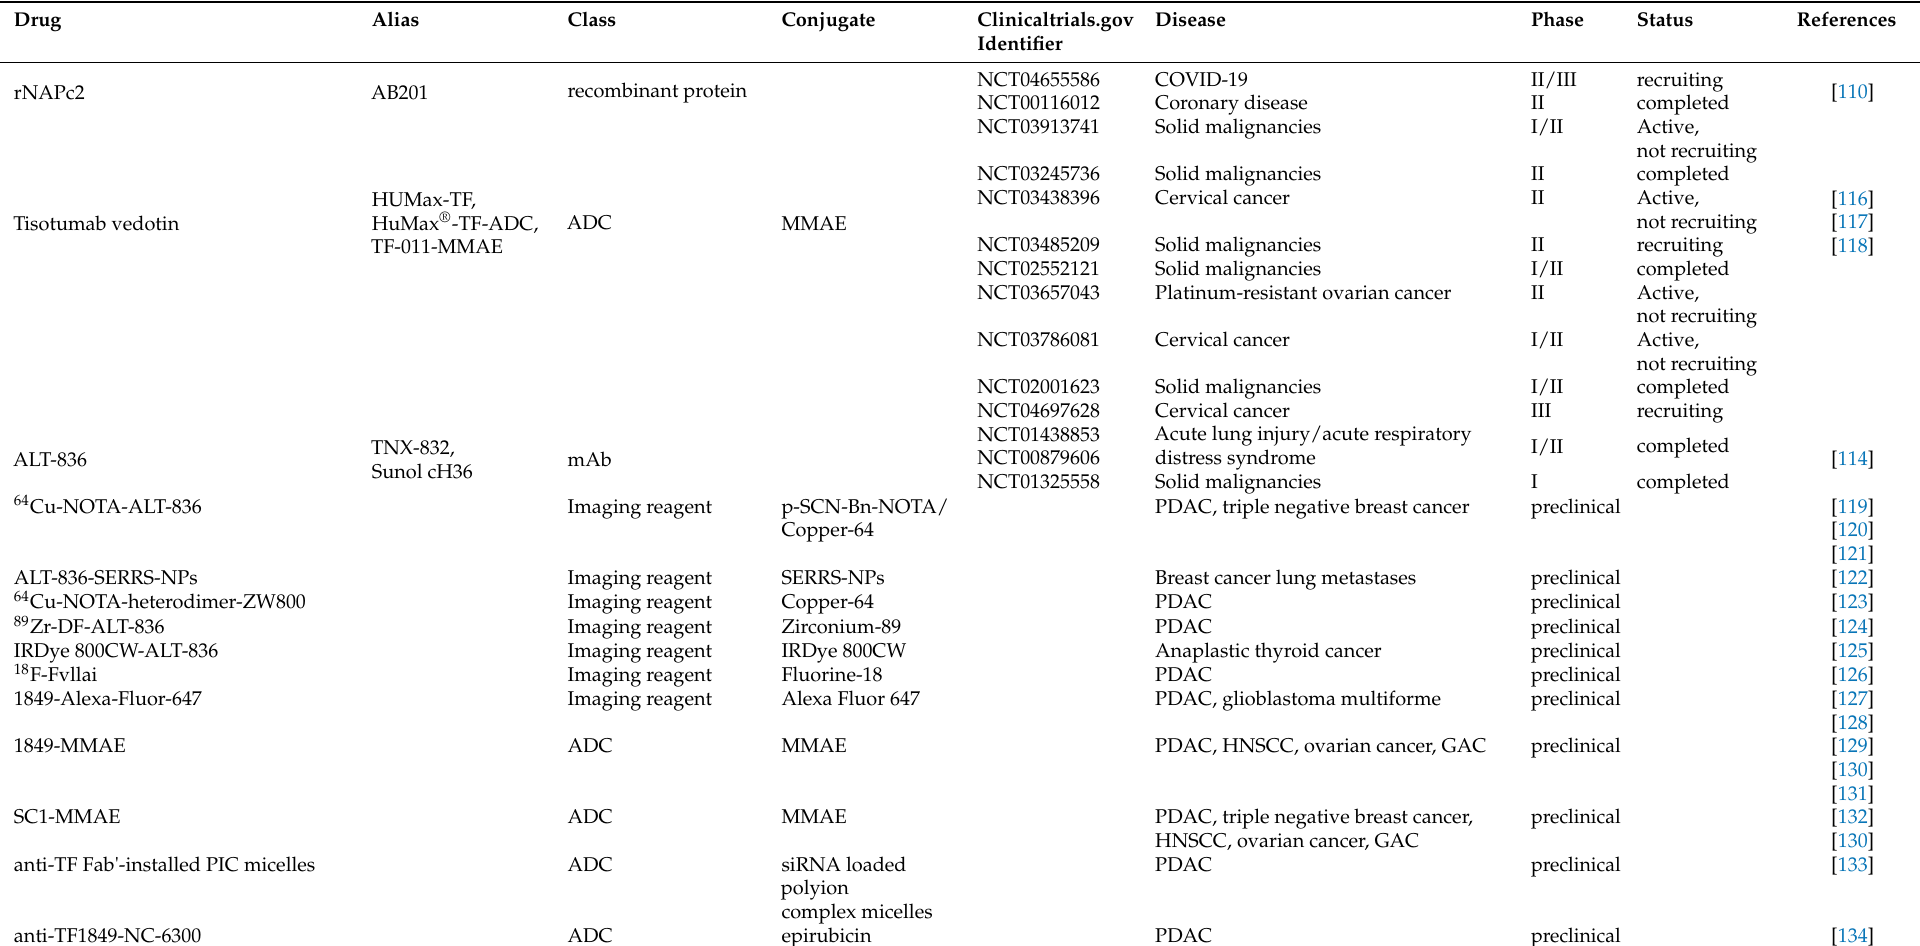
Table 1. Tissue factor-focused therapeutics developed during the past 5 years that are currently in preclinical studies, or in various stages of clinical evaluation. Cancer types are abbreviated as PDAC (pancreatic ductal adenocarcinoma), HNSCC (head and neck squamous cell carcinoma), and GAC (gastric